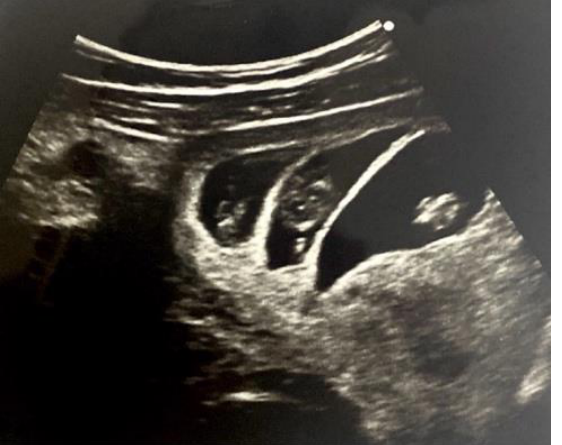
Figure 1. Transabdominal scan at 9 weeks of pregnancy confirms a trichorionic triamniotic (TCTA) pregnancy. Clear visualization of the two lambda signs and thick intertwin membranes, composed of a central layer of chorionic tissue sandwiched between two layers of amnion, therefore multi-layered, more